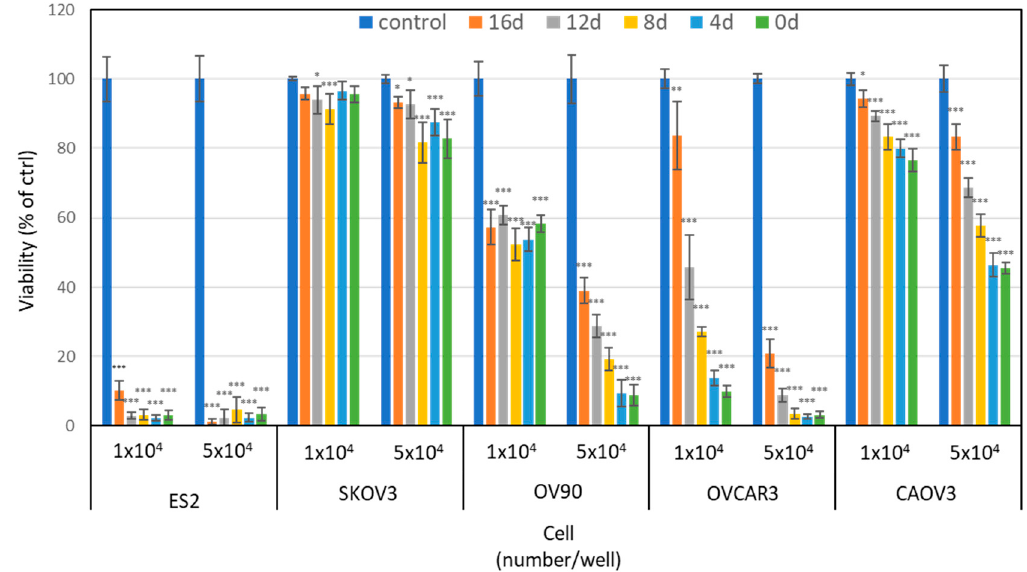
Figure 1. Antitumor effect of plasma-activated medium (PAM) on various ovarian cancer cells, depending on the cell type, cell number, and PAM storage periods. The antitumor effect of PAM was analyzed on day 0, 4, 8, 12, and 16 after the preparation. Two cell numbers (5 × 10 3 and 1 × 10 4 per well) were analyzed for the antitumor effect. The data are mean ± SD. Three independent experiments were performed. A one-way ANOVA with Tukey’s post hoc test for equal variances was carried out between control and each storage period of PAM treated cells. Statistics are shown as *** p < 0.001; ** p < 0.01; * p < 0.05.